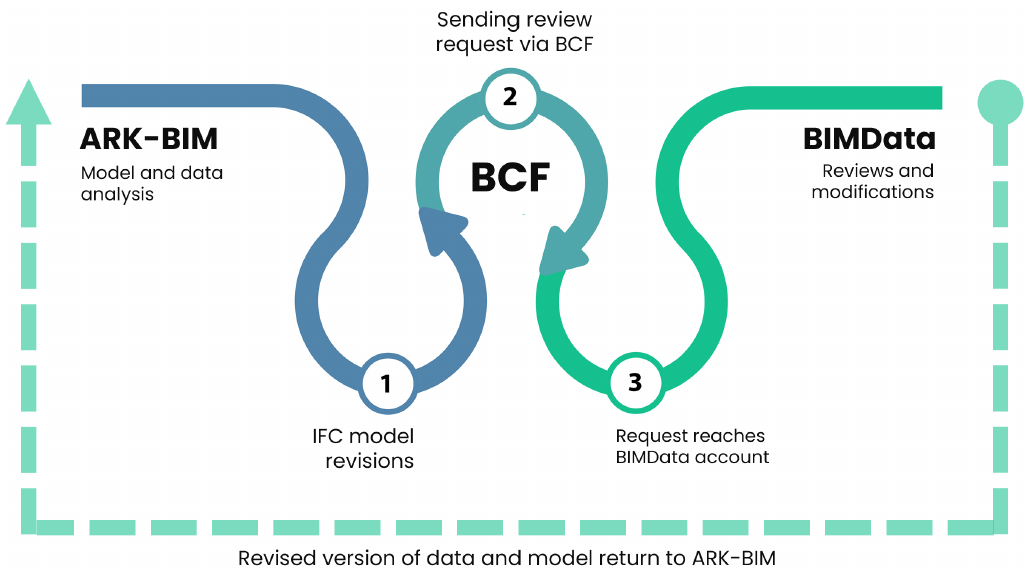
Figure 6. BIM Collaboration Format option behaviour with ARK-BIM and BIMData.